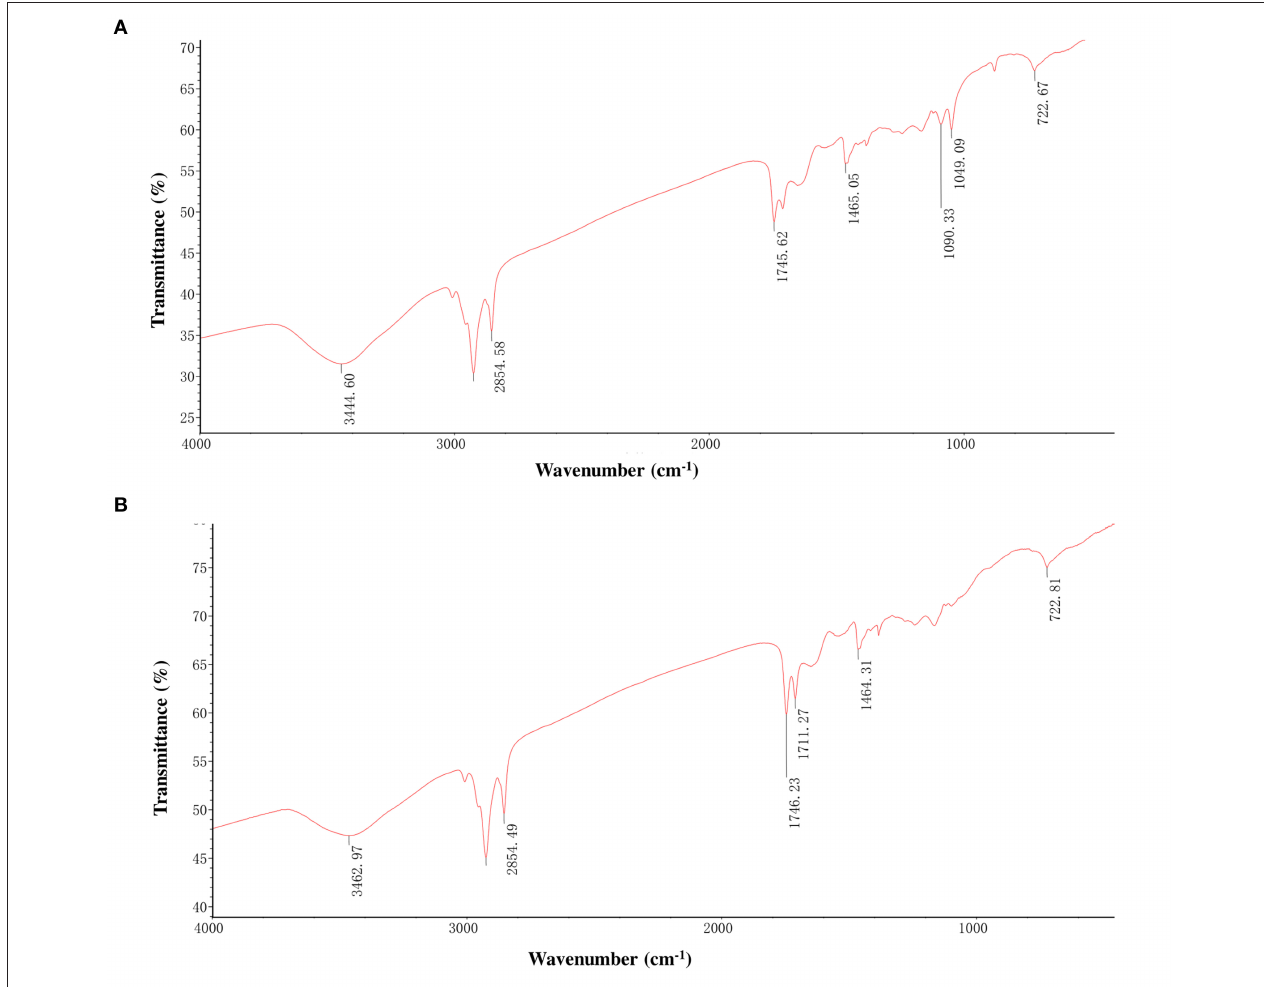
FIGURE 3 | Fourier transforms infrared (FT-IR) spectra of melanins isolated from black sesame (A) and brown sesame (B) seeds.